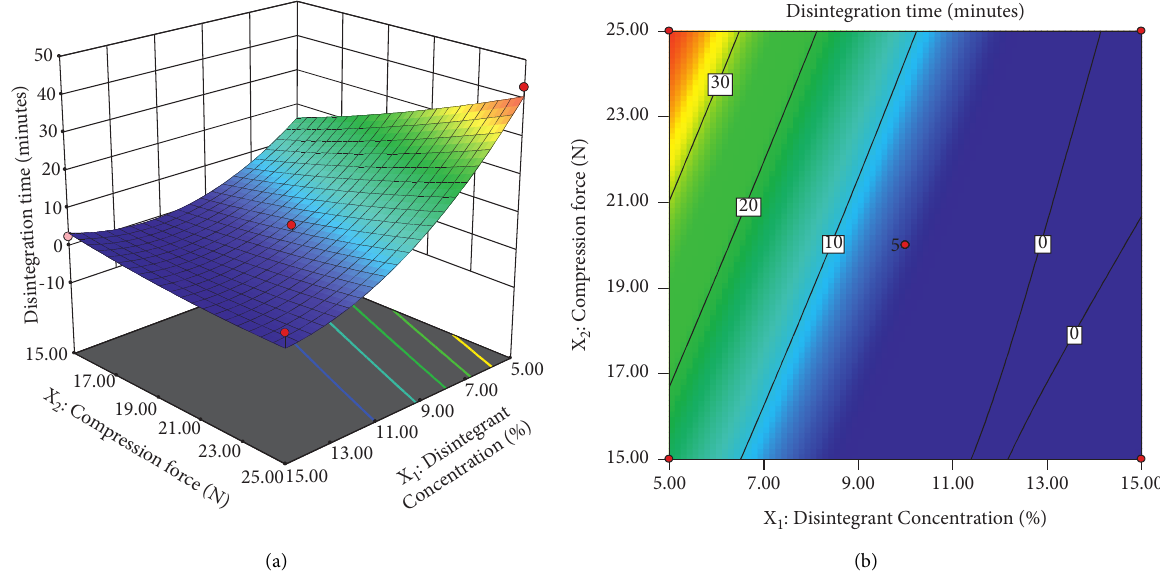
Figure 4: Surface response (a) and contour plot (b) of DT as a function of compression pressure and